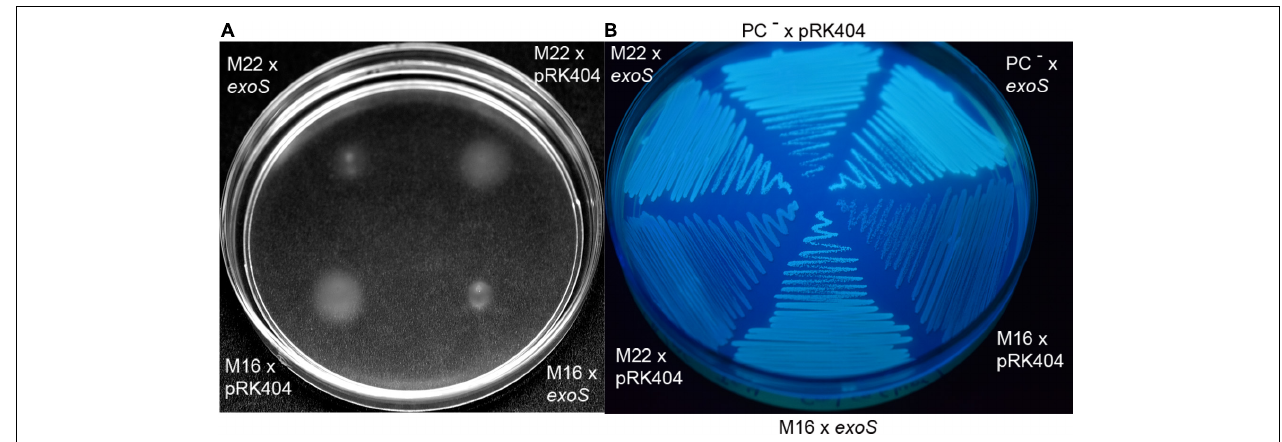
FIGURE 8 | Intact ExoS suppresses swimming and increases exopolysaccharide formation in ExoS-impaired correlated suppressor mutants M16 and M22. (A) Swimming of ExoS-impaired correlated suppressor mutants M16 and M22 harboring a plasmid with the wild type version of exoS or harboring the empty plasmid pRK404 after 4 d of incubation on LB/MC+-containing swim plates (0.3% agar) in the presence of 4 µ g/ml tetracycline. (B) Exopolysaccharide production of ExoS-impaired correlated suppressor mutants M16 and M22 harboring a plasmid with the wild type version of exoS or harboring the empty plasmid pRK404 after 3 days of incubation.